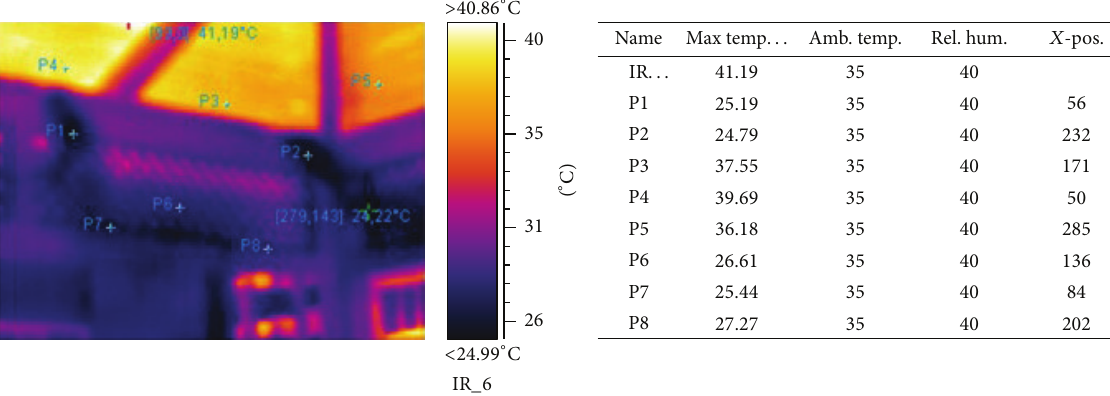
Figure 7: The thermal camera images and information of the arbor subregion, two nozzles.